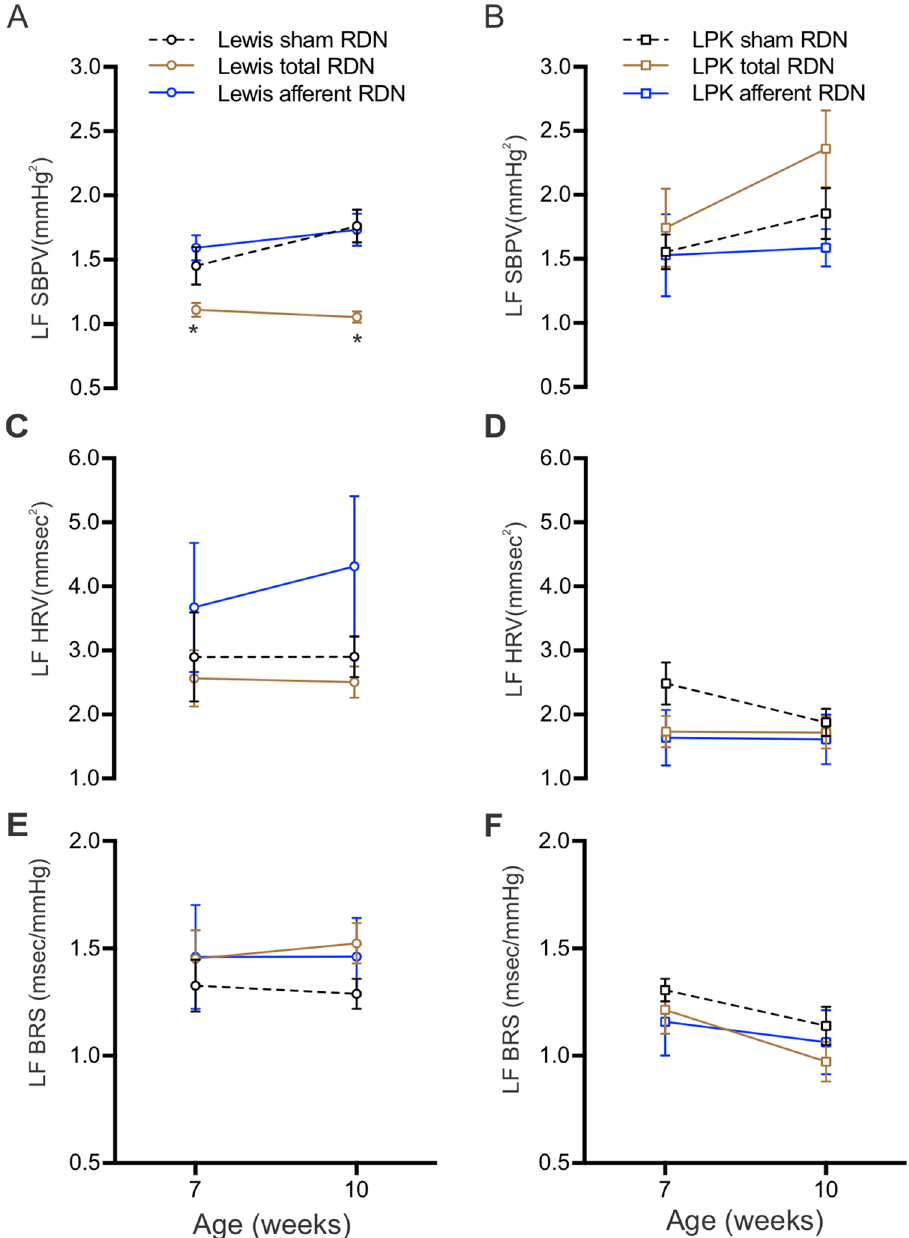
Figure 3. The effect of RDN on low frequency (LF) systolic blood pressure variability (SBPV; A , B ), heart rate variability (HRV; C , D ) and baroreceptor sensitivity (BRS; E , F ) in Lewis ( A , C , E ) and LPK ( B , D , F ) rats at 7 and 10 weeks of age after sham, total and afferent RDN procedures. Data is expressed as mean ± SEM. *indicates P < 0.05 difference between sham and total RDN groups at 7 or 10 weeks old, analysed using two-way ANOVA and Bonferroni’s post hoc analysis. N values at 7 and 10 weeks for Lewis sham = (10, 11); Lewis total = (14, 13); Lewis afferent = (9, 10) respectively and for LPK sham = (13, 11), LPK total = (14, 12) and LPK afferent = (9, 8),